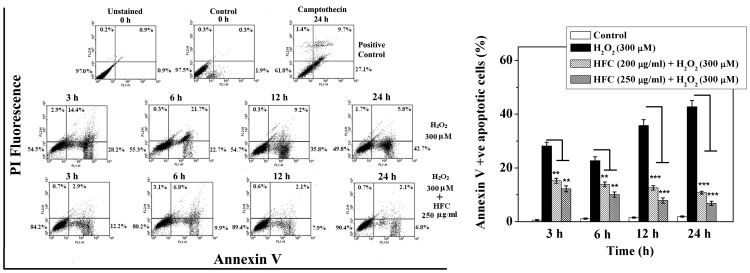
Inhibitory effects of HFC polysaccharide on H2O2-induced apoptosis of WI38 cells.WI38 cells were incubated in presence (200 and 250 µg/mL) or in absence of HFC polysaccharide for 1 h followed by the treatment with 300 µM H2O2 in both the cases for varying periods of time (0–24 h). Cellular apoptosis was assayed by annexin V-FITC and PI counterstaining and analyzed with flow cytometry. Camptothecin was used as positive control. Dual parameter dot plot of FITC fluorescence (x-axis) versus PI fluorescence (y-axis) is represented as logarithmic fluorescence intensity. Quadrants: upper left necrotic cells, lower left live cells, lower right apoptotic cells, and upper right necrotic or late phase of apoptotic cells. The corresponding data are shown as bar graphs. Results are representative of three independent experiments performed in triplicate and are represented as mean ± SD. A one-way analysis of variance (ANOVA, Bonferroni corrections for multiple comparisons) was performed, where significant level stands for ** p<0.001, *** p<0.0001.